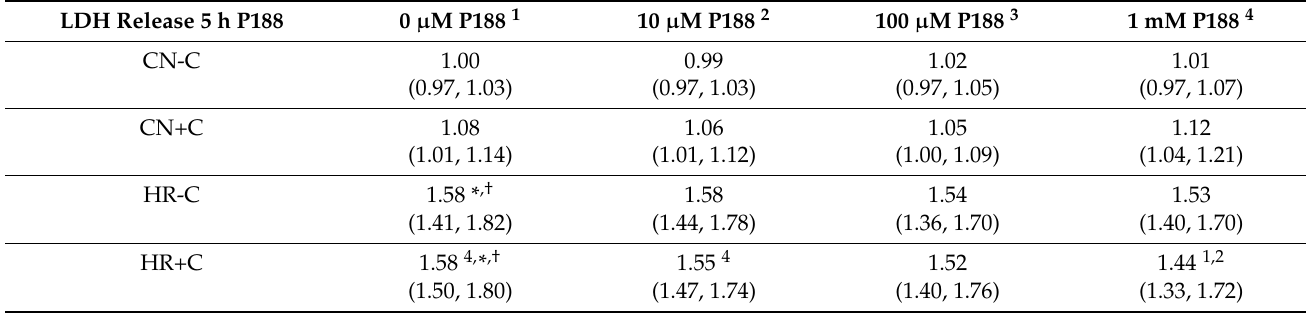
Table A2. Cytotoxicity/membrane damage after 5 h injury and treatment with 0 µ M, 10 µ M, 100 µ M, and 1 mM of P188. Data from Figure 5 visualized as table (median, 25th, 75th percentile); p < 0.05; n = 12–18 experiments/group. Significances between different concentrations of P188 are displayed as superscripted numbers, significances between 0 µ M P188 CN-C, CN+C, HR-C, and HR+C are represented by symbols (* vs. CN-C 0 µ M P188, † vs. CN+C 0 µ M P188). Abbreviations: C, compression; CN, control/normoxia; h,